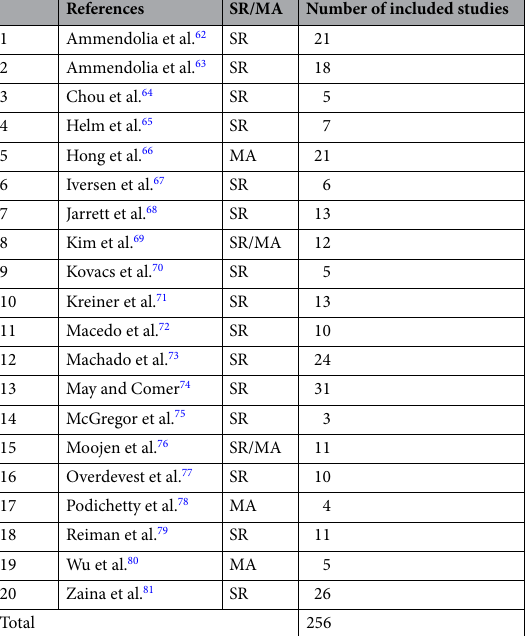
Table 1. Characteristics of included SR and/or MA (n = 20). SR systematic review; MA